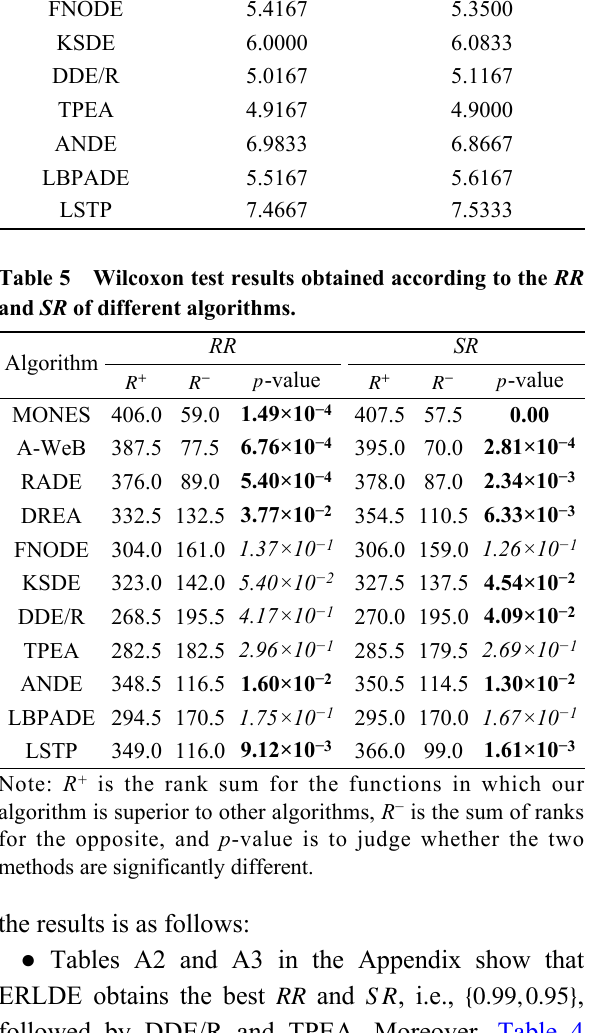
Table 4 Average rankings of 12 algorithms obtained by the Friedman test in terms of root ratio ( RR ) and success rate ( SR ).